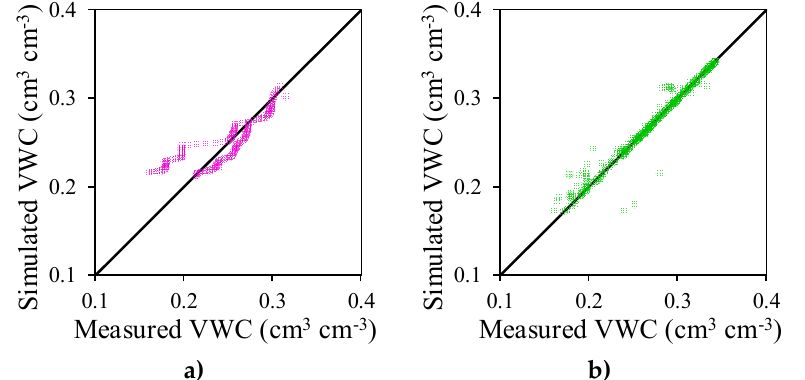
Figure 8. Comparison of the measured and the simulated soil volumetric water content by ( a ) HYDRUS-1D and ( b ) the random forest model.